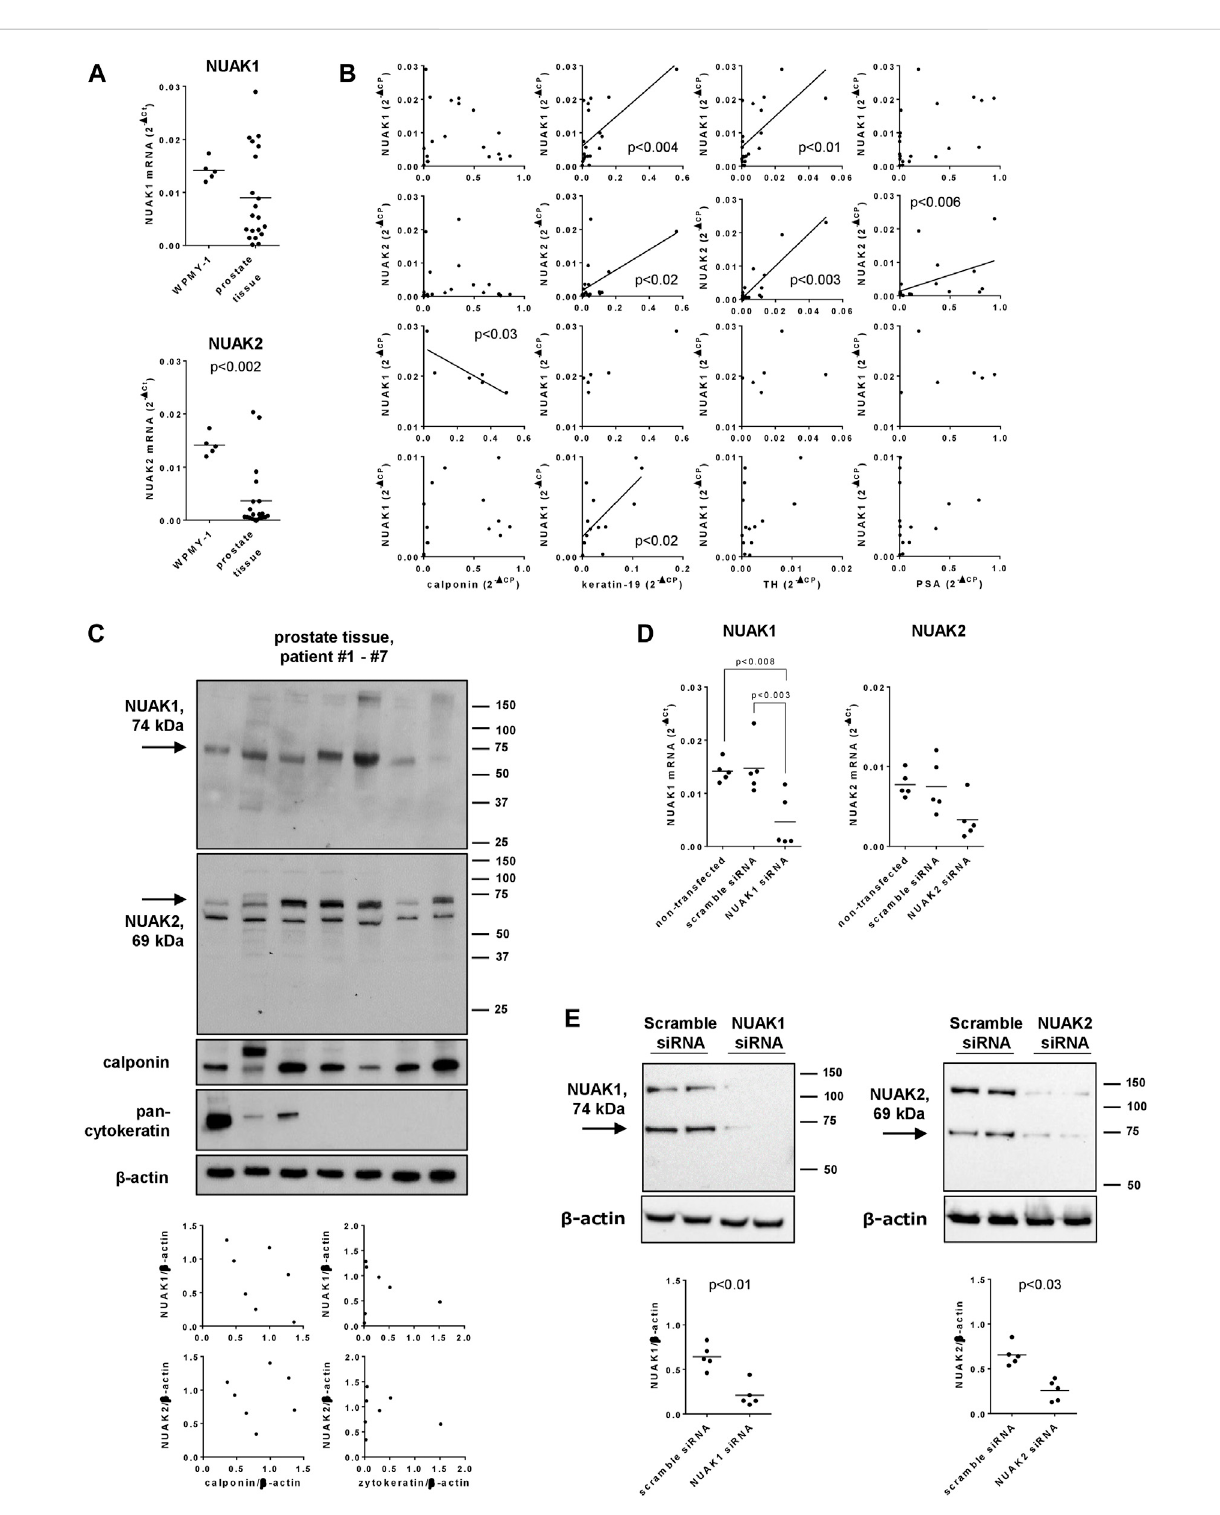
FIGURE 1 Expression and silencing of NUAK1 and NUAK2 in WPMY-1 cells and human prostate tissues. WPMY-1 cells and human prostate tissues were analyzed for NUAK1 and NUAK2 mRNA by RT-PCR (A,B,D) , or by Western blot analysis with antibodies raised against NUAK1 and NUAK2 (C,E) . (A) Comparison of NUAK1 and NUAK2 mRNA expression between WPMY-1 cells and human prostate tissues. (B) Correlation analyses, with mRNA levels of NUAK1, NUAK2, calponin (marker for smooth muscle), keratin-19 (marker for glandular, epithelial cells), tyrosin hydroxylase (TH, marker for catecholaminergicneurons)andprostate-speci fi cantigen(PSA,markerforBPH)inhumanprostatetissue.CtvaluesforNUAK1inprostatetissuesshowed a binominal distribution, so that groups with high (ddCt > 0.01) and low (ddCt < 0.01) were analyses separately, in addition to analyses with all examined tissues. (C) Western blot analyses of human prostate tissues with NUAK1 and -2 antibodies, and for calponin and pan-cytokeratin. Diagrams show correlationanalysesofbothNUAK isoformswithcalponinandpan-cytokeratin,after quanti fi